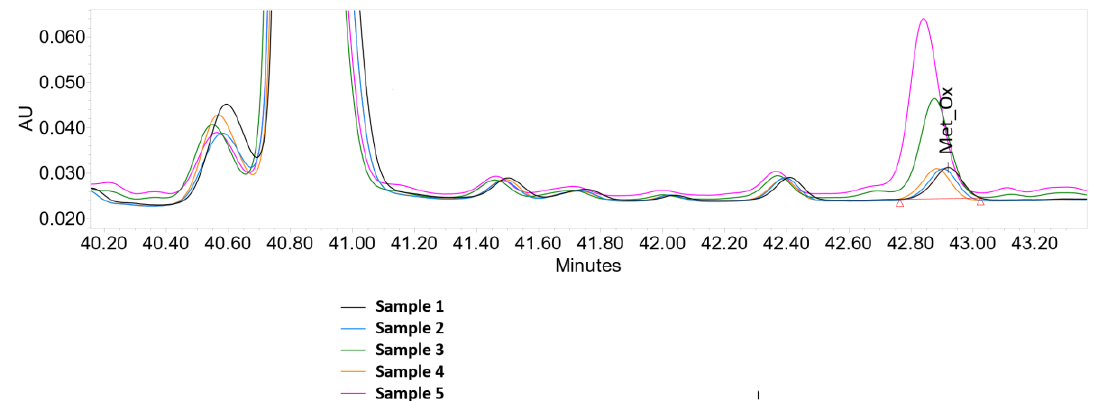
Figure 4. HPLC-UV peptide map of the therapeutic protein. Fragments were prepared by protein digestion, as described in the Materials and Methods Section.